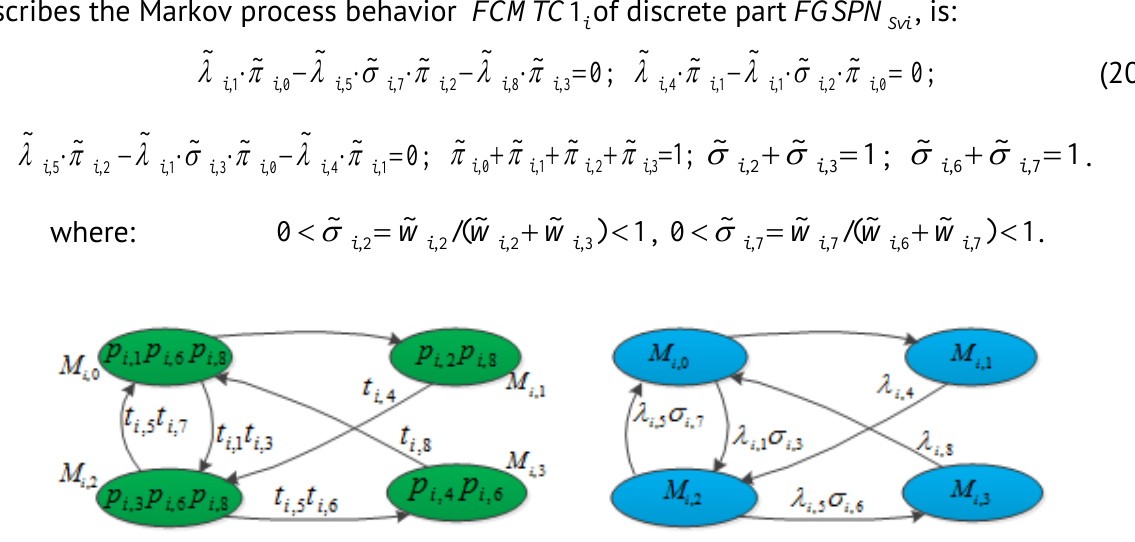
AcG 1 ; b) FSHPN 1 : a) i i